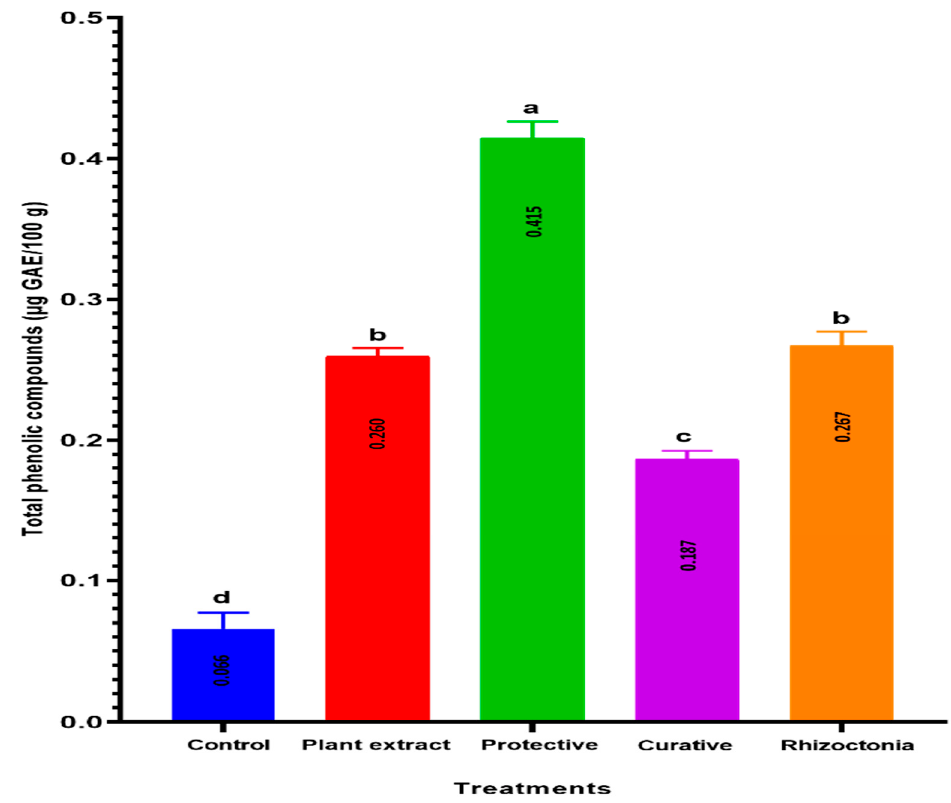
Figure 6. Total phenolic compounds of all treatments used in this study. The different letters on top of the columns mean the data values were significantly different at p ≤ 0.05.